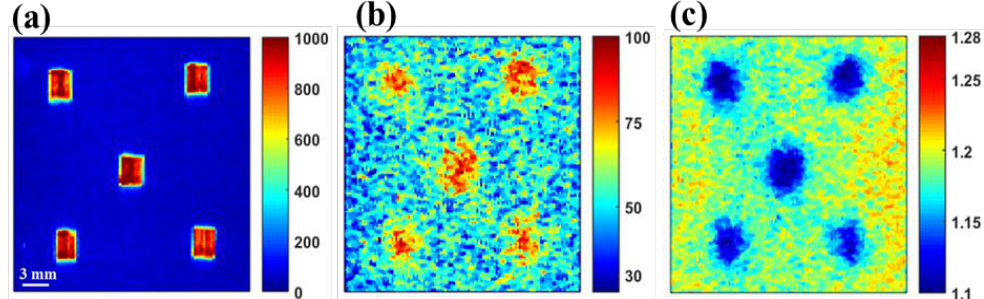
Figure 6. Raman band (1000 cm − 1 ) images of polystyrene crystals exposed to the laser without any cover ( a ), covered with a 2 mm thick layer of wheat flour ( b ), and the spectral angle mapper (SAM) rule image of polystyrene crystals covered with a 2 mm thick layer of wheat flour ( c ). The intensity scales are in arbitrary units.